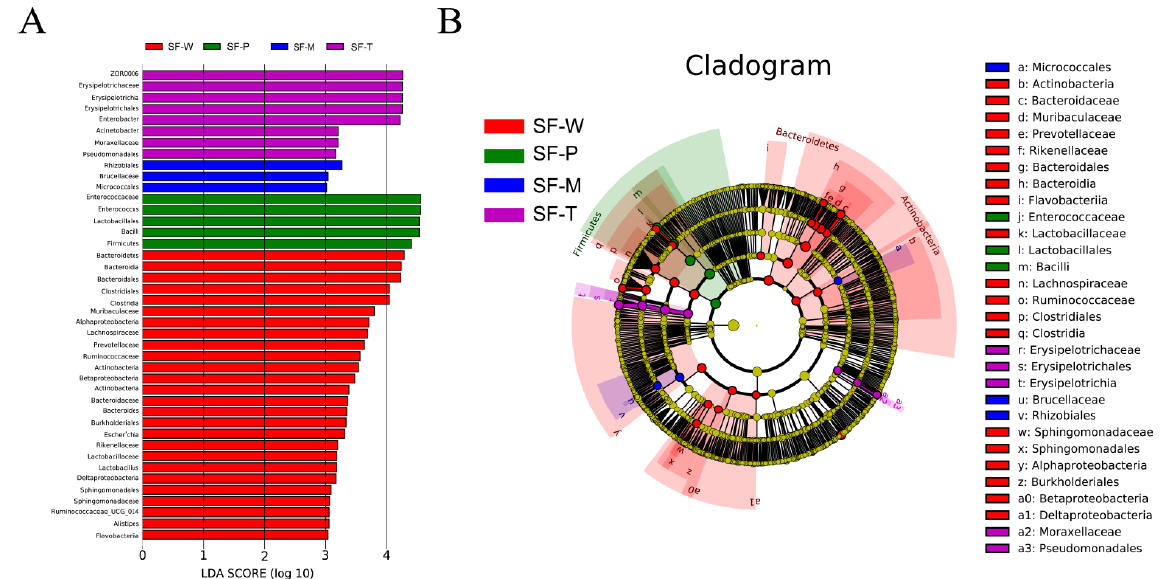
Figure 5. Microbial taxa associated with different host plants. ( A ) Association of specific microbiota taxa with the group of 4 host plants by linear discriminant analysis (LDA) effect size (LEfSe). ( B ) The taxonomic cladograms obtained from LEfSe analysis of 16S rDNA sequences are shown. Small circles highlighted in different colors (red, green–blue or purple) in the diagram represent the taxa that were significantly elevated in the respective group. Yellow circles indicate taxa that were not significantly differentially represented ( p > 0.05).